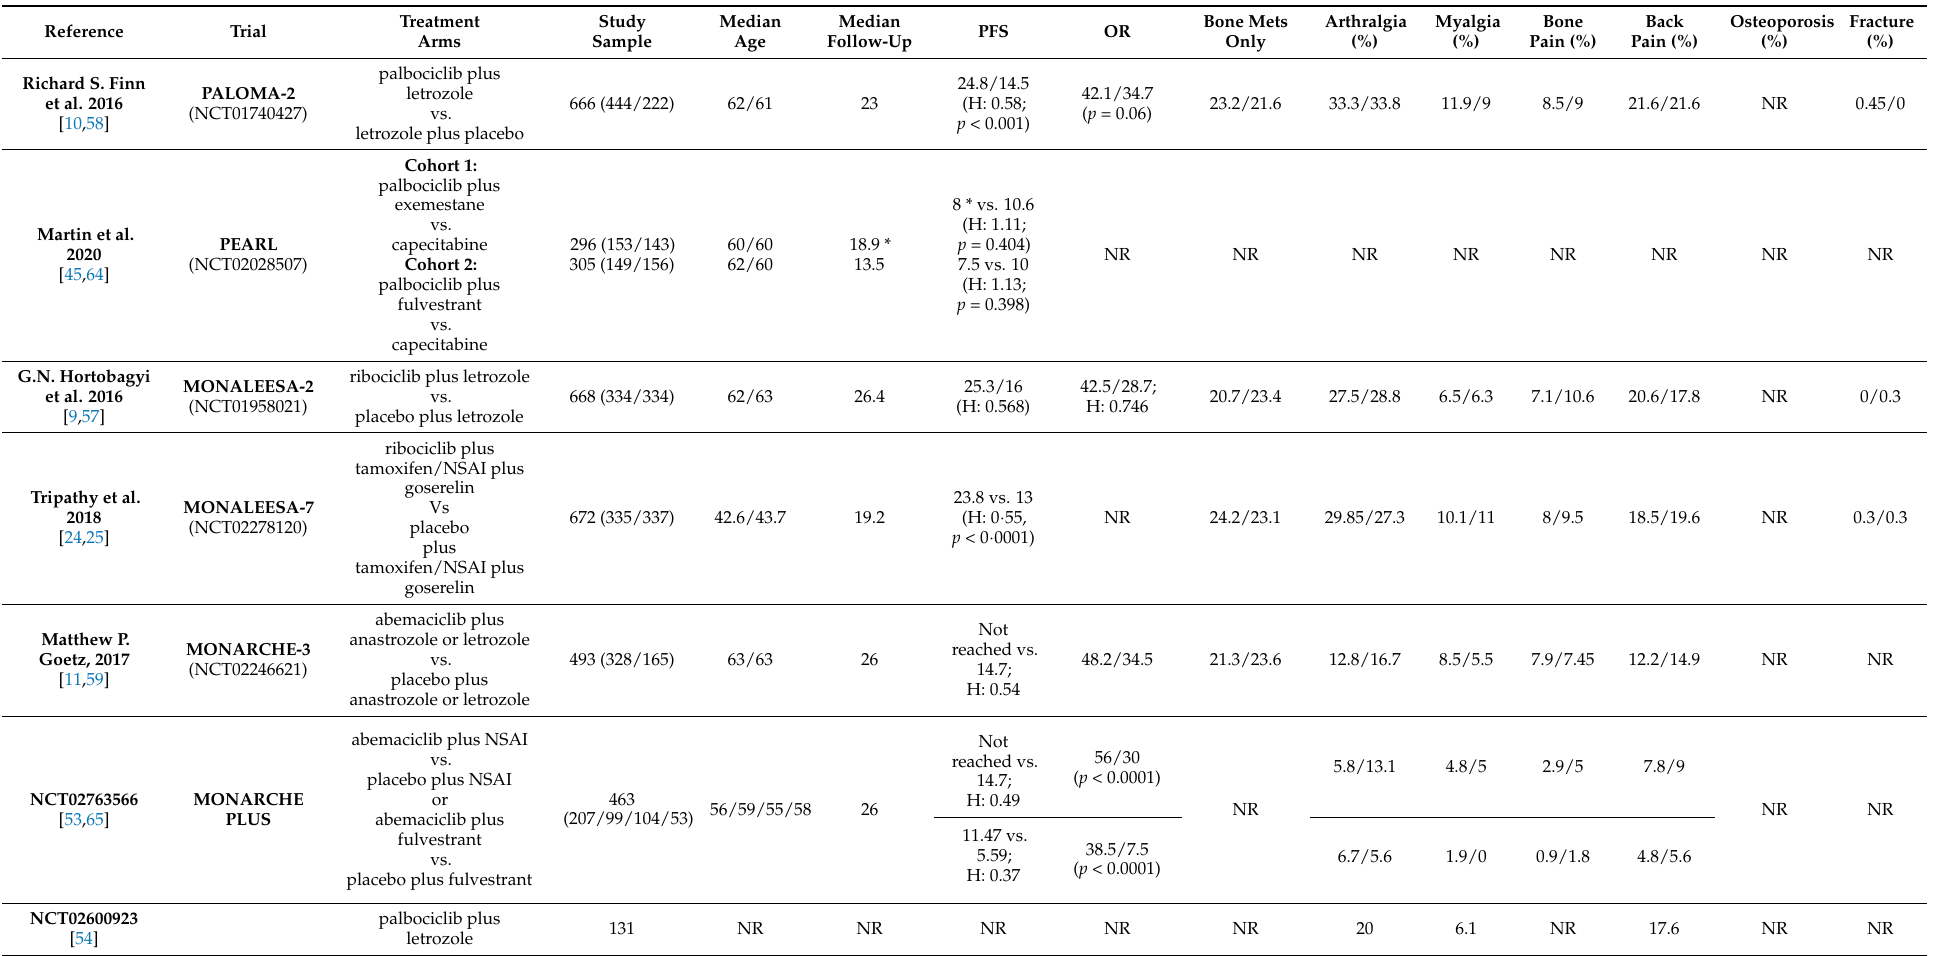
Table 2. Phase III randomized trials of CDK4/6 inhibitors in combination with AIs in postmenopausal women with advanced/metastatic breast